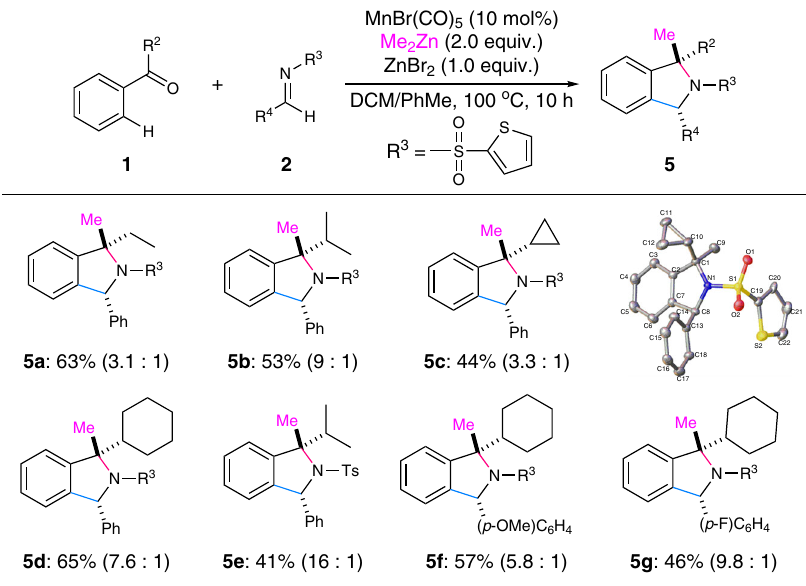
Fig. 7 Substrate scope for the three-component reaction giving isoindolines 5 . Reaction conditions: 1 (2.0 mmol), 2 (0.5 mmol), MnBr(CO) 5 (0.05 mmol), Me 2 Zn (2.0 mmol, 1.2 M in toluene), ZnBr 2 (0.5 mmol), DCM (0.1 M), 100 °C, 10 h. The ratio of diastereoisomers (dr) was shown in parentheses. DCM dichloromethane NATURE COMMUNICATIONS | 8: